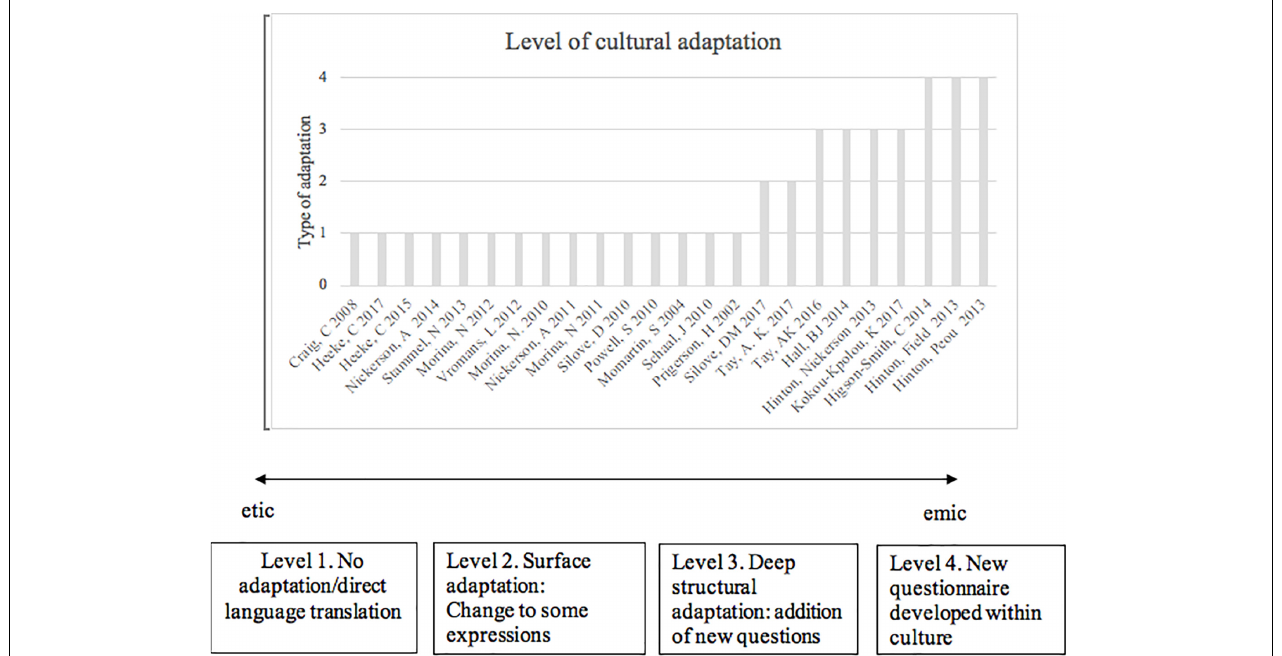
FIGURE 2 | Level of cultural adaptation and continuum of included studies according to approach.